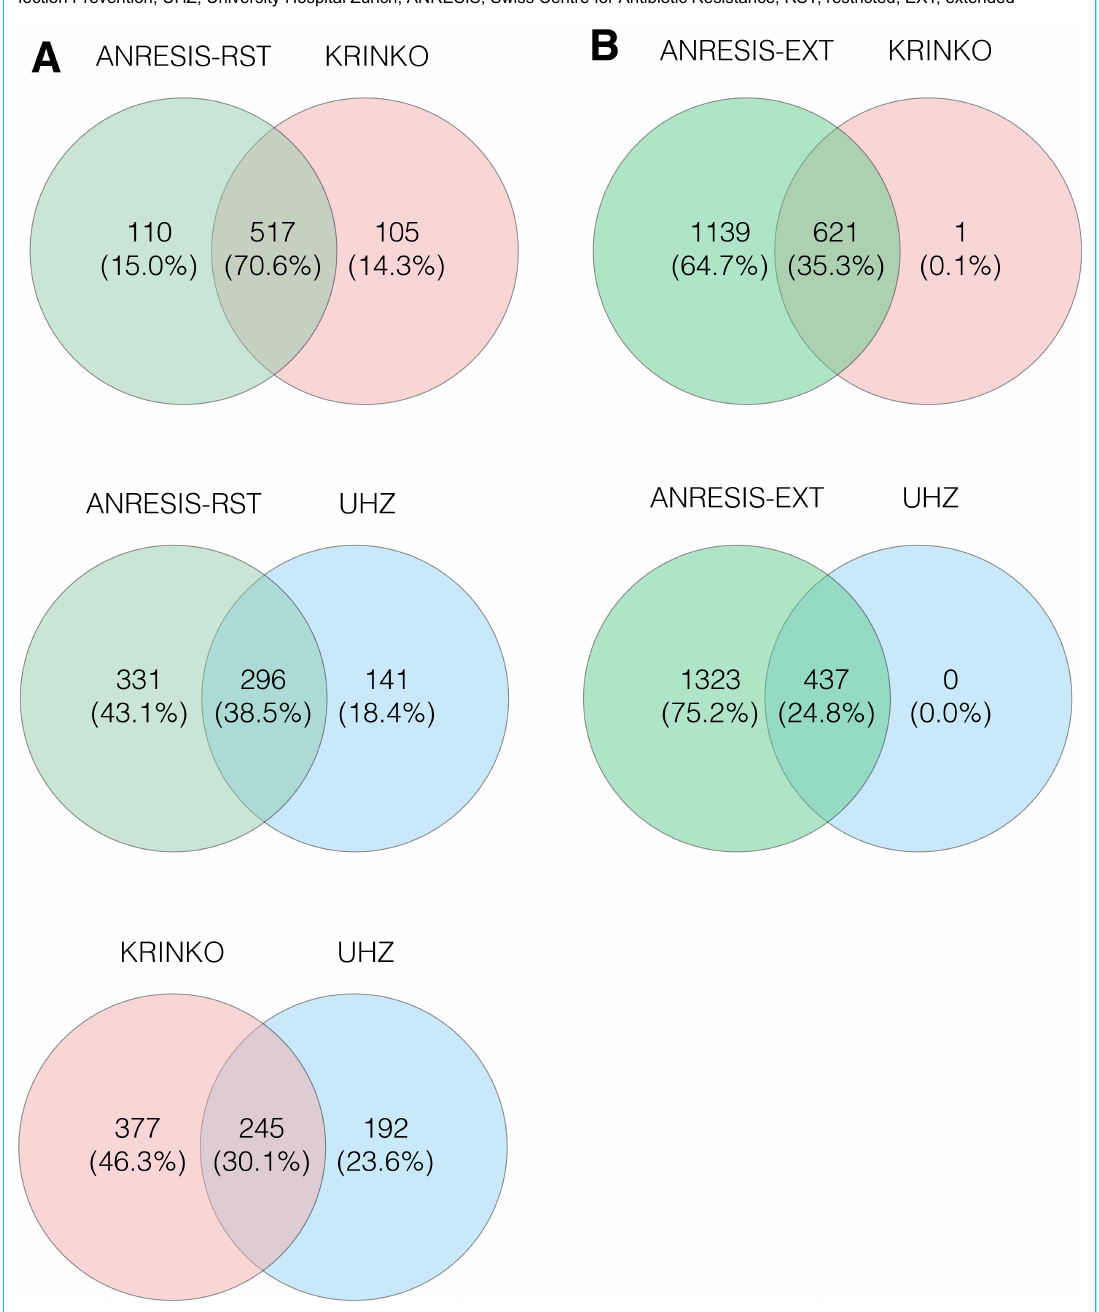
Figure S4: A) Overlap in the number of Enterobacterales isolates classified as MDR-Enterobacterales following the application of the KRINKO, UHZ and ANRESIS-RST definitions. B) Overlap in the number of Enterobacterales isolates classified as MDR-E following the